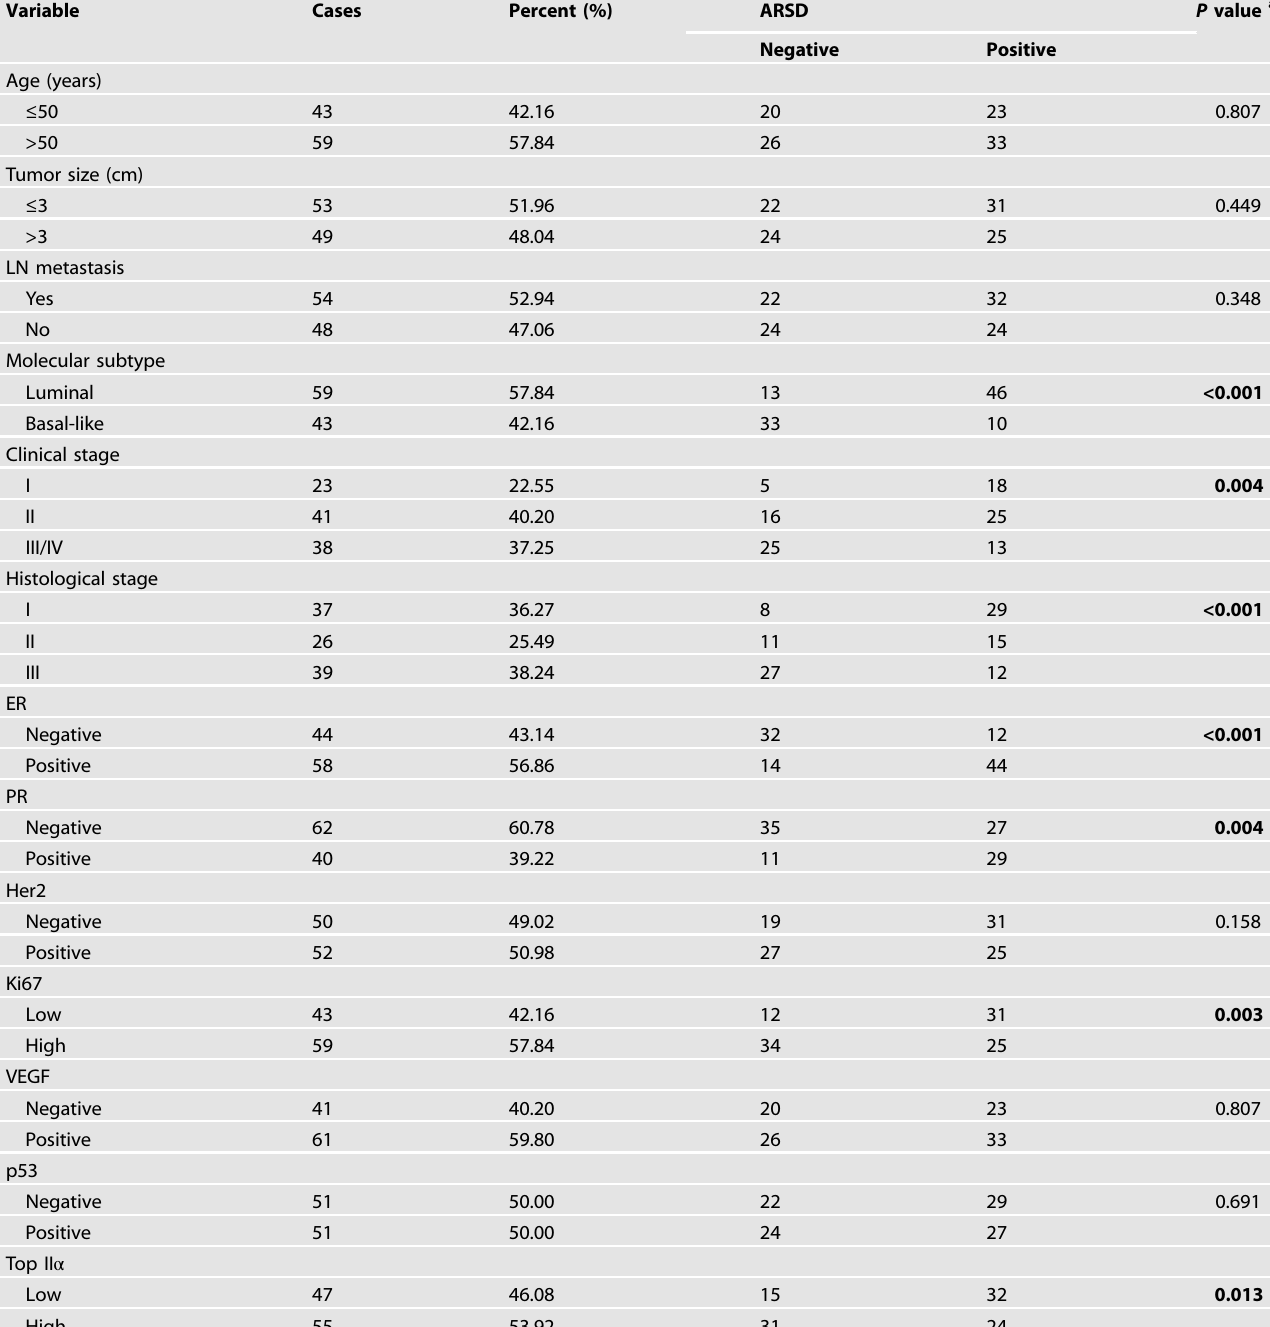
Table 1. Demographic and clinicopathologic characteristics of breast cancer